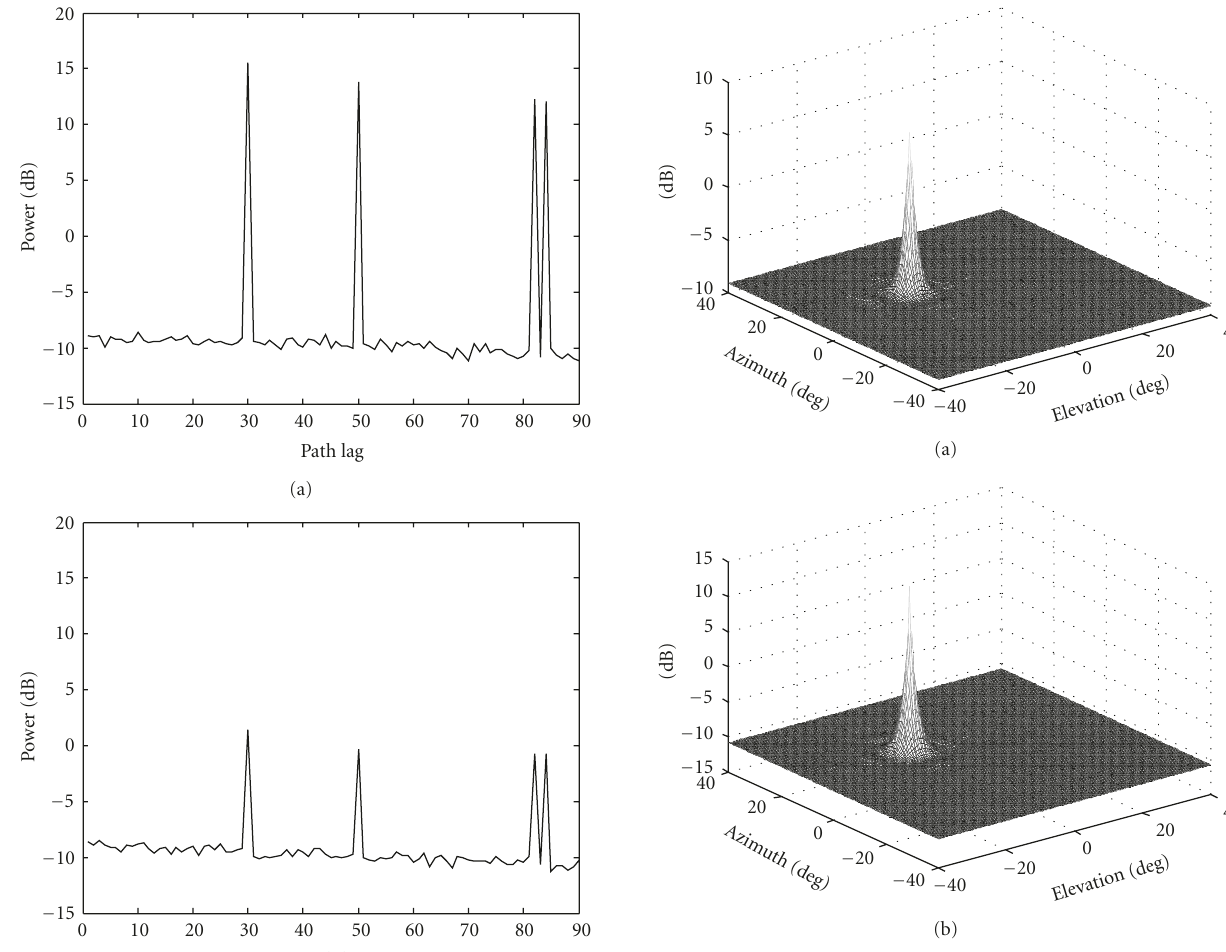
Figure 3: (a) MPDR solution for the lag = 30 (snr 1 = 7dB). (b) high-resolution (HR) solution for the lag = 30 (snr 1 =